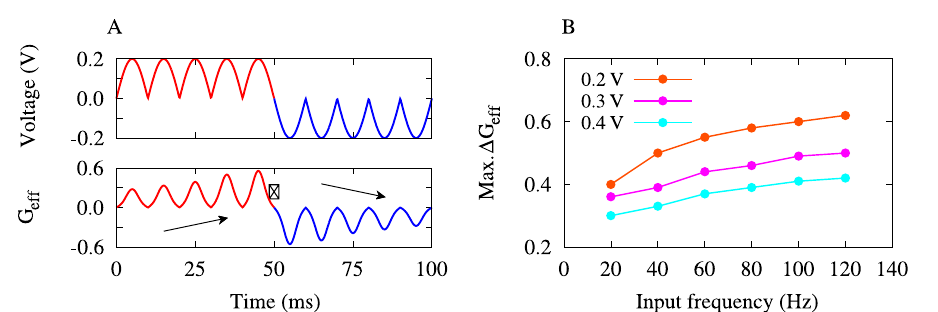
Fig 7. Voltage-dependent learning in the MTJ. ( A ) (Top) A sinusoidal voltage signal with amplitude (strength) V max = 0.2 V and frequency ω = 100 Hz is applied to the MTJ. (Bottom) Calculated effective conductance of the MTJ in response to the applied voltage. Arrows show LTP-like and LTD-like behavior of the effective conductance depending on the polarity of the input signal. (B) Frequency dependency of learning in the MTJ for different values of the signal strength. The molecule-electrode coupling strength was γ =